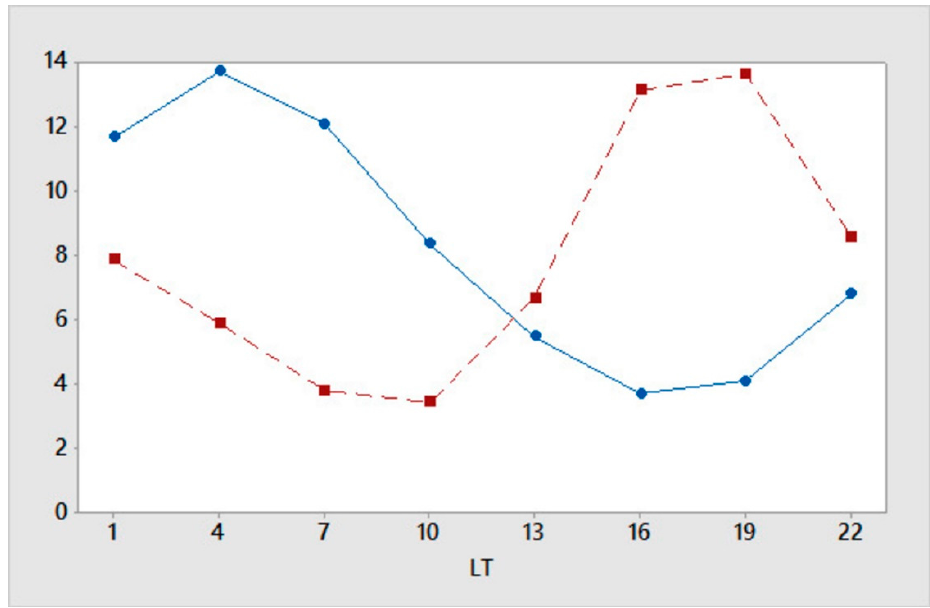
Figure 9. Variation of hourly mean rainfall (mm h − 1 ) over VCZ for summer (May–October) in the continent (dotted) and the ocean (solid), considering the period 1998–2015. The domain considered is shown in the Figure (1a).